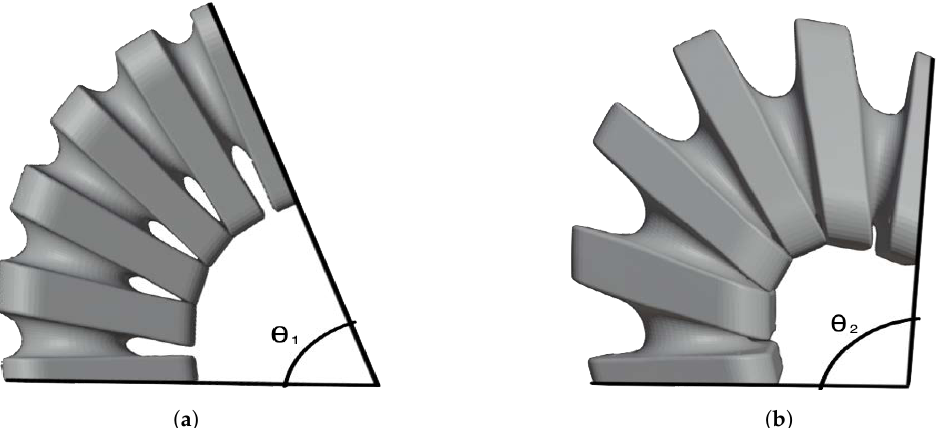
Figure 2. Comparing panels ( a , b ), the maximum curvatures in the different directions of the soft arm show that angle θ 2 is greater than angle θ 1 . ( a ) Maximum curvature of the soft arm, angle θ 1 , when bending in the direction of the vertices. ( b ) Maximum curvature of the soft arm, angle θ 2 , when bending in the direction of the edges.